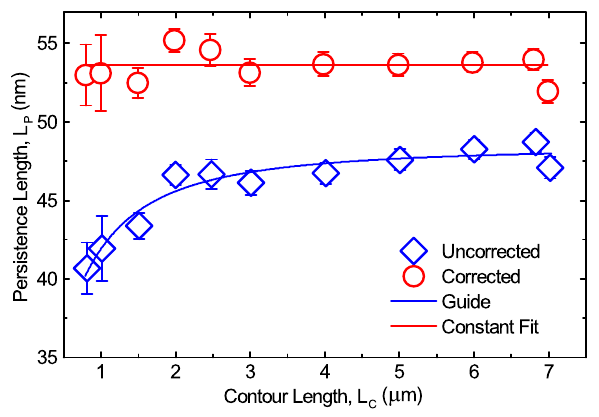
Figure 8. Uncorrected and corrected L P for simulated data showing the same trend as the experimental results. A decrease in measured persistence length as a function of decreasing contour length, when taking the DNA extension as the arithmetic mean m z of the microsphere position data (blue diamonds). By following the correction procedure described in the text, the persistence length is corrected to a constant value for all contour lengths (red circles). Lines are guides to the eye and error bars are standard error of the